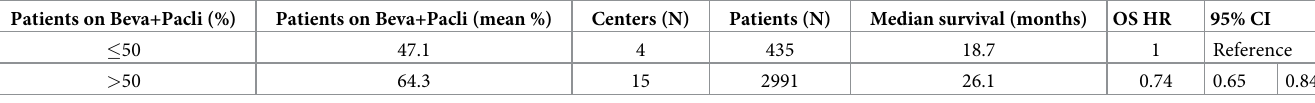
Table 2. Median survival and HR for centers grouped by % of patients treated. Patients on Beva+Pacli (%) Patients on Beva+Pacli (mean %) Centers (N) Patients (N) Median survival